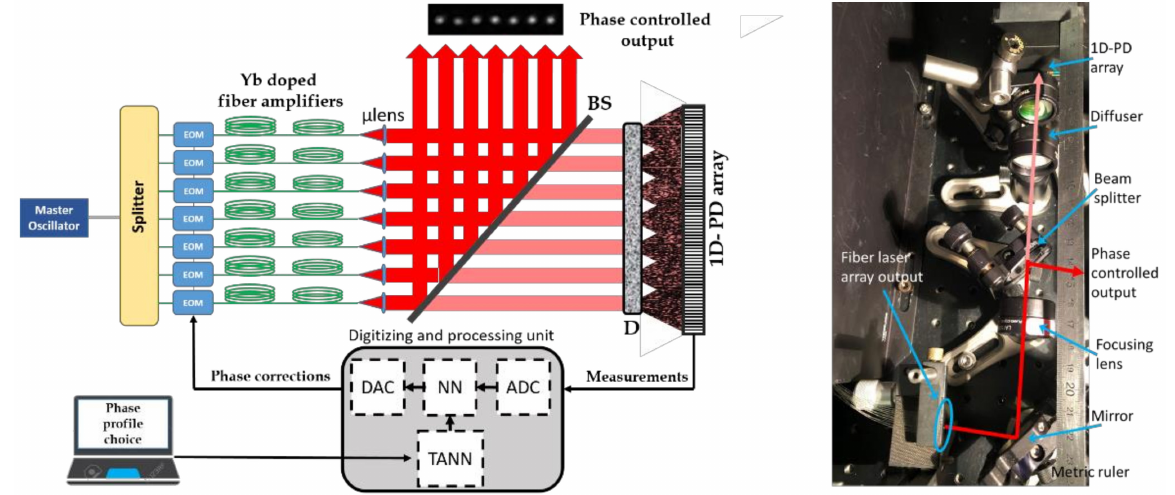
Figure 5. Left, setup of the 7-fiber amplifier array used in the reported experiments on-demand phase control using NN. The master oscillator was a semiconductor laser. EOM denotes LiNbO3 electro-optic modulator and the double-stage Ytterbium-doped fiber amplifiers were polarization maintained with 1W output power, µ lens stands for microlens array, BS for beam splitter, D for diffuser. Right, photograph of the 1D-array output and of the phase analysis